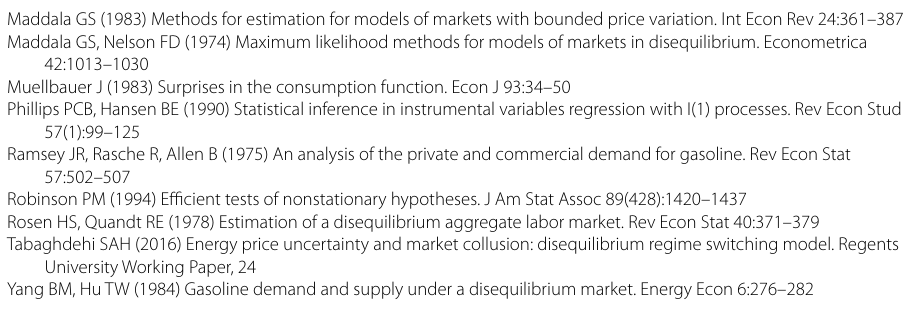
Tabaghdehi SAH (2016) Energy price uncertainty and market collusion: disequilibrium regime switching model. Regents University Working Paper, 24 Yang BM, Hu TW (1984) Gasoline demand and supply under a disequilibrium market. Energy Econ